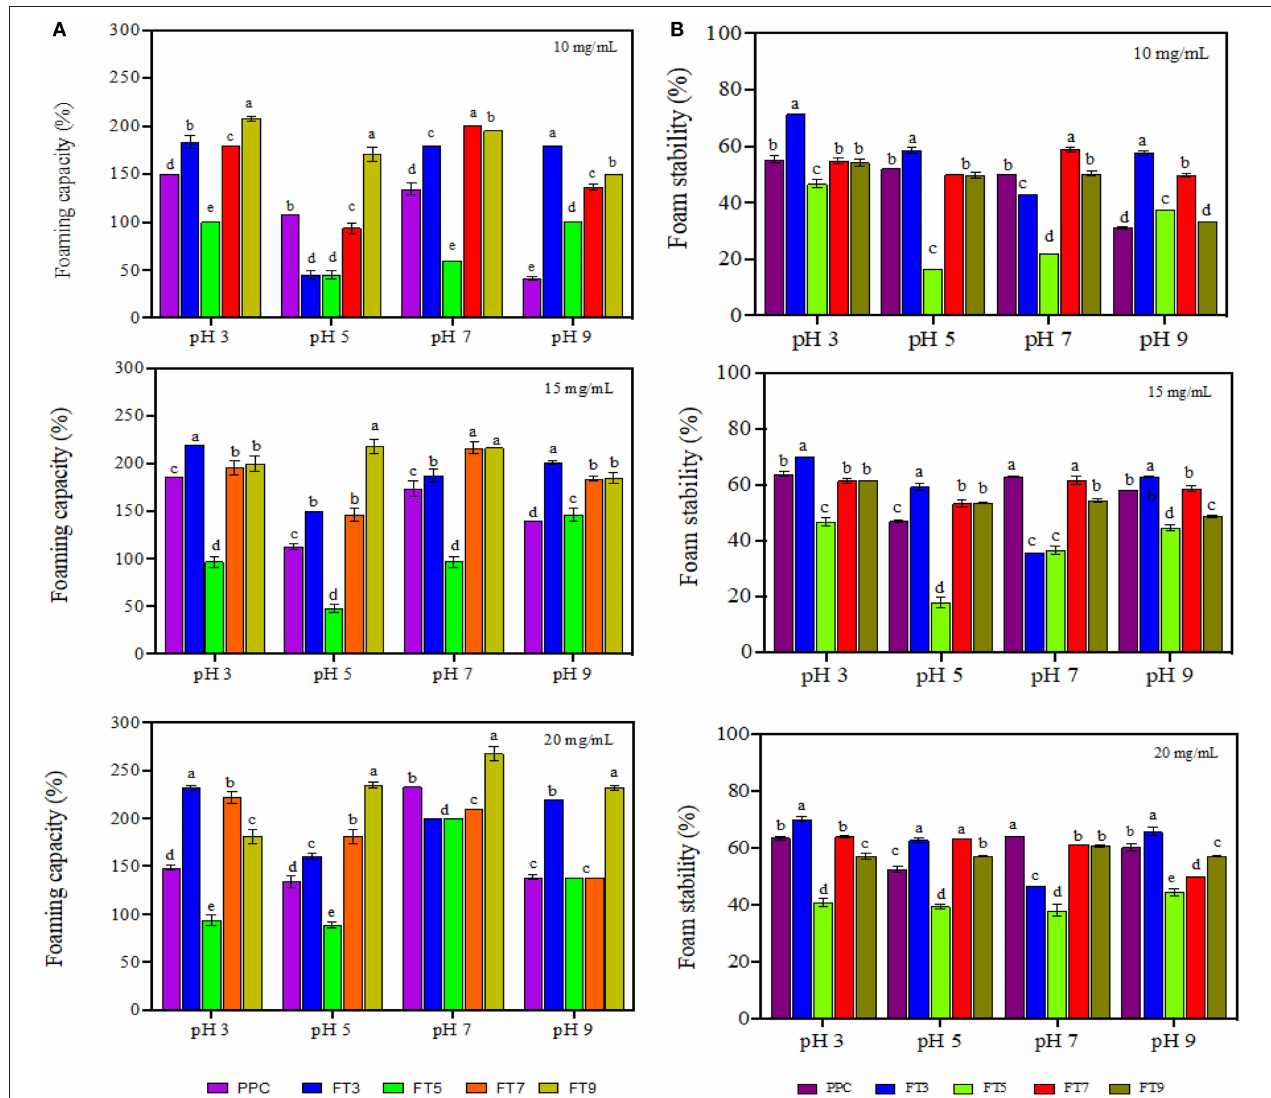
FIGURE 6 | (A) Foaming capacity and (B) foam stability of pea protein concentrate (PPC) and > 50 protein aggregates. PPC was heated at 100 ◦ C and varying pH, centrifuged and the supernatant passed consecutively through 30 and 50 kDa membranes. The final retentate from the 50 kDa membrane was collected as FT3, FT5, FT7, and FT9 for heat treatments at pH 3.0, 5.0, 7.0, and 9.0, respectively. For each plot, bars with different letters have different mean values ( p <